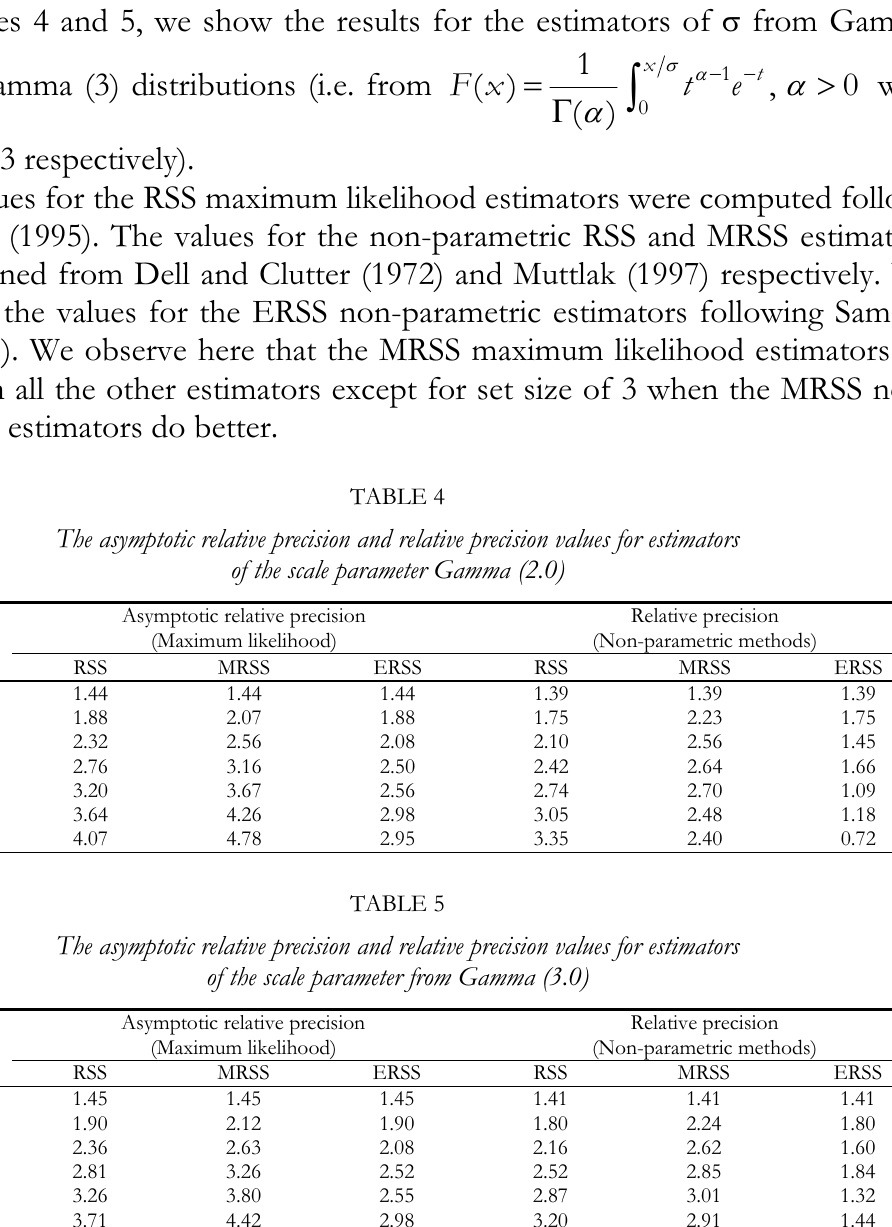
Relative precision (Non-parametric methods) Set